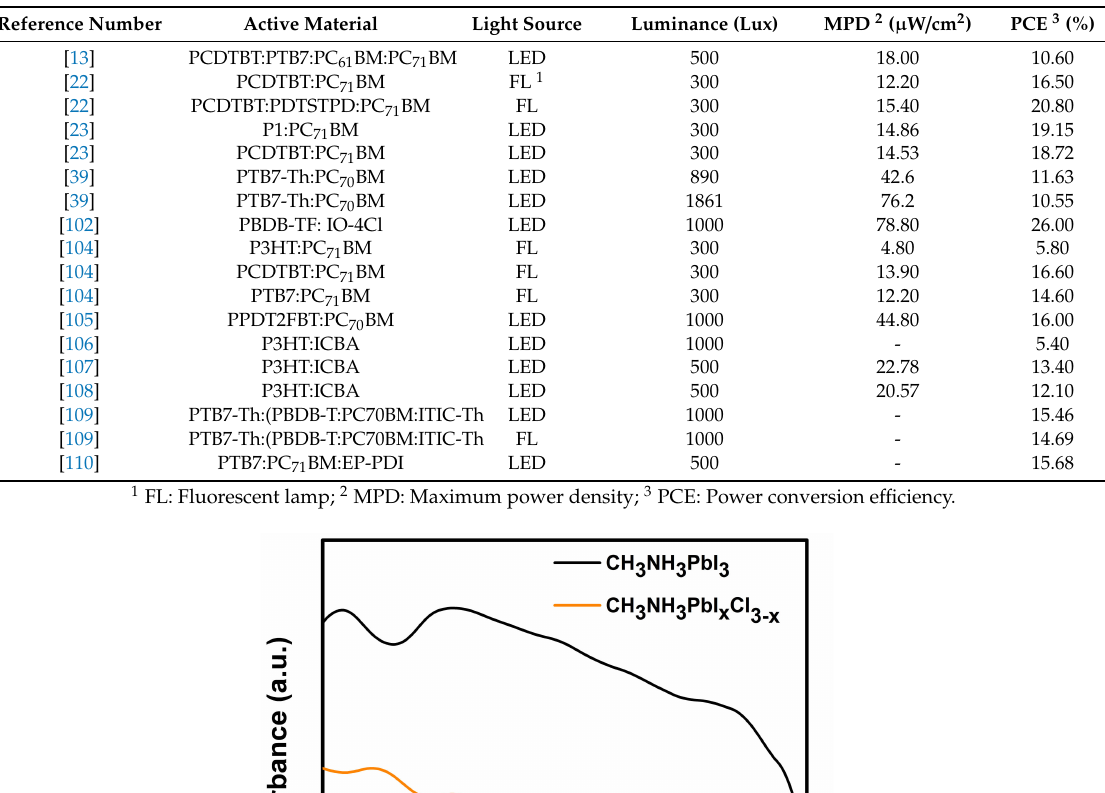
Table 3. Summary of previously reported studies on di ff erent OSCs for indoor applications.